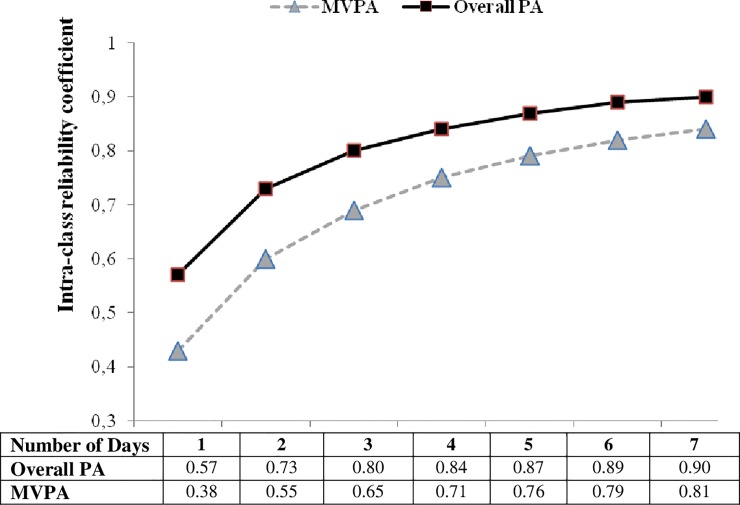
Intraclass reliability coefficient for the number of days monitoring overall PA and MVPA.